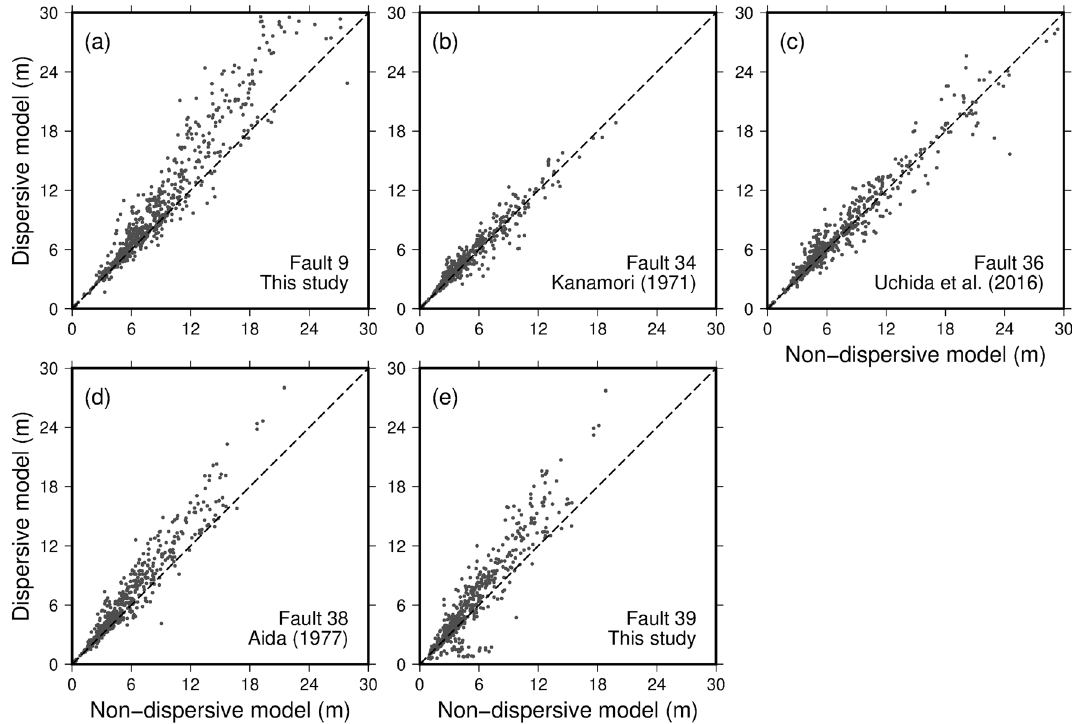
Figure 6. Correlation between tsunami inundation heights obtained from the non-dispersive and dispersive calculations. Fault models ( a ) 9 and ( e ) 39 are proposed in this study. Fault models ( b ) 34, ( c ) 36 and ( d ) 38 are based on Kanamori 20 , Uchida et al. 21 and Aida 55 ,